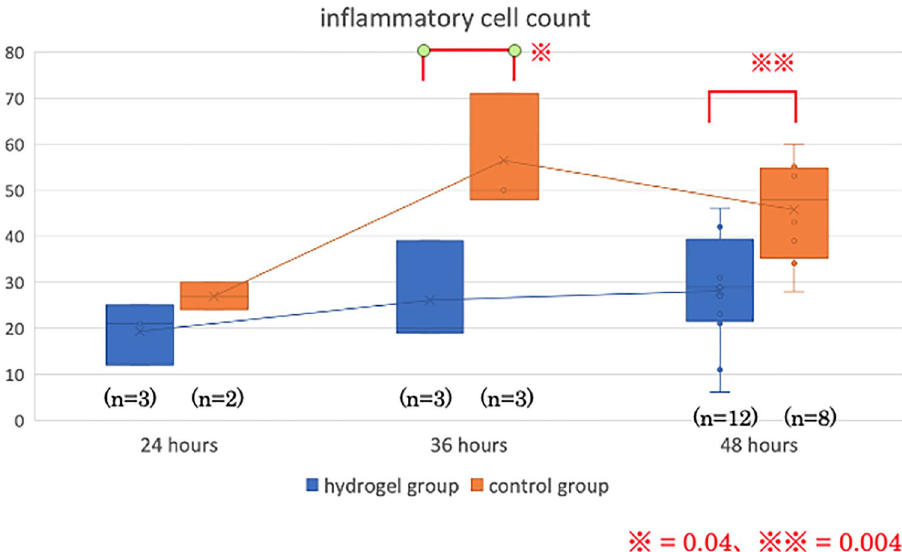
Figure 3. The number of inflammatory cells per 100 μm 2 in the deep submucosal layer in the mucosal defect area in the hydrogel and control